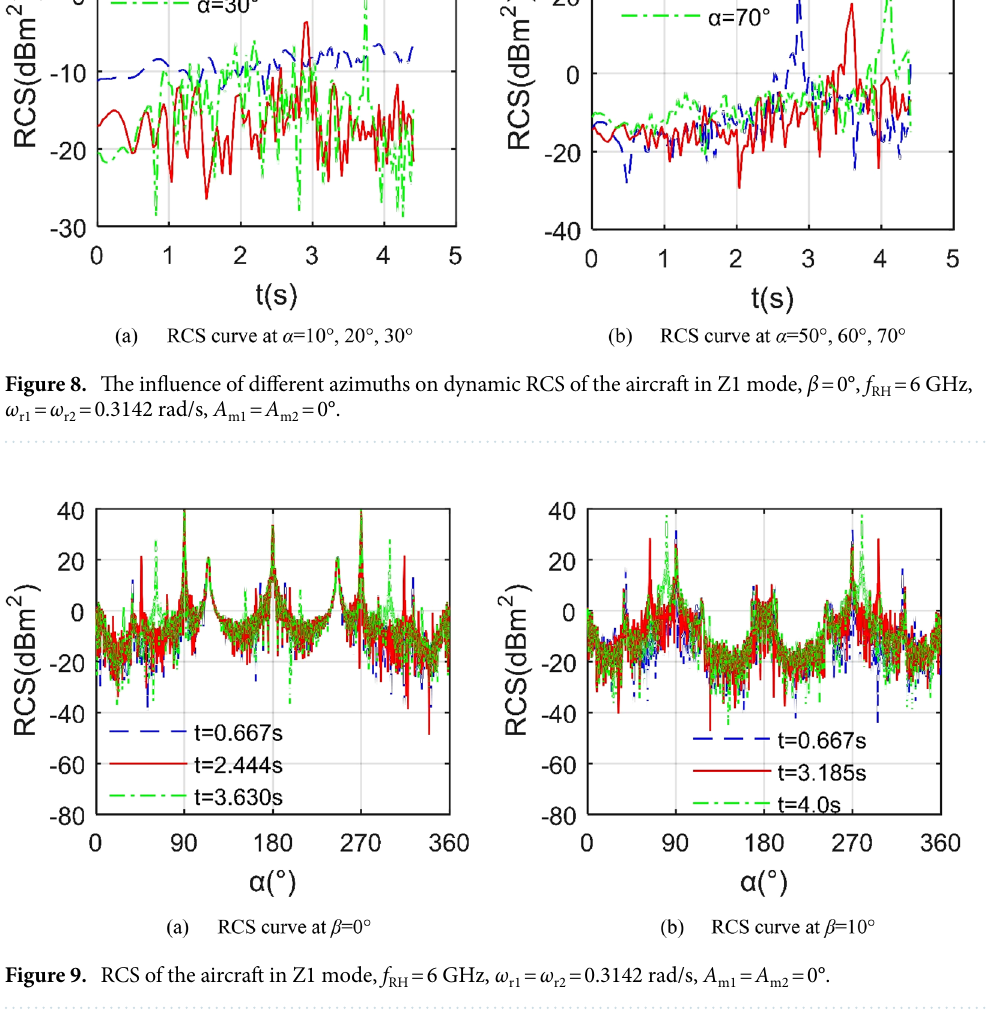
surface are mainly concentrated on the fuselage head and the leading edge of the wing, and the deflection of the outer wing has little effect on the illumination area. When α = 20°, the fluctuation range of the RCS curve has been greatly increased, ranging from − 26.53 to − 3.521 dBm 2 , which is mainly due to the scattering effect of the front edge of the outer wing and its nearby curved surface. This increased volatility is also reflected in the RCS curve of α = 30°, where the maximum value has reached 1.093 dBm 2 . For the case of α = 50°, the fluctuating curve has an obvious large peak, which is 23.85 dBm 2 at 2.852 s, because the incident wave at this time is incident sideways, the upper surface of the outer wing 1 becomes a dynamic scattering source. This prominent peak feature also exists on the curves of α = 60° and α = 70°, where the maximum values are 17.88 dBm 2 and 32.32 dBm 2 respectively. These results indicate that the azimuth angle has a greater impact on the dynamic RCS of the aircraft in the Z1 mode, and the RCS curve near the side fluctuates more obviously than the head. Figure 9 reveals that at different instantaneous moments, the RCS ~ α curve of the aircraft will show obvious differences, including the mean value and the local peak value. For the RCS curve at t = 0.667 s, the two largest peaks appear in the lateral direction, 39.13 dBm 2 at α = 90.25° and 39.21 dBm 2 at α = 270.3° respectively, where the mean RCS of the curve is equal to 15.553 dBm 2 . When t = 2.444 s, the RCS curve has a peak of 21.58 dBm 2 at α = 46°, because the outer wing 1 deflected 43.992° downwards, the end face of the mid-section wing 1 is exposed, and the upper surface of the outer wing 1 is also not conducive to deflecting radar waves to a non-threatening direction. For the case of t = 3.630 s, the mean index of the RCS curve increased to 16.003 dBm 2 , while the change of the maximum peak is not obvious. When β = 10°, the peak and average levels of the RCS curve with t = 4.0 s are significantly higher than the other two, where the mean of the RCS curve at t = 0.667 s is 7.373 dBm 2 , that at t = 3.185 s is 6.227 dBm 2 as shown in Table 4. It is worth noting that increasing the elevation angle from 0° to 10° significantly reduces the average index of the RCS curve at t = 0.667 s. These results show that although the